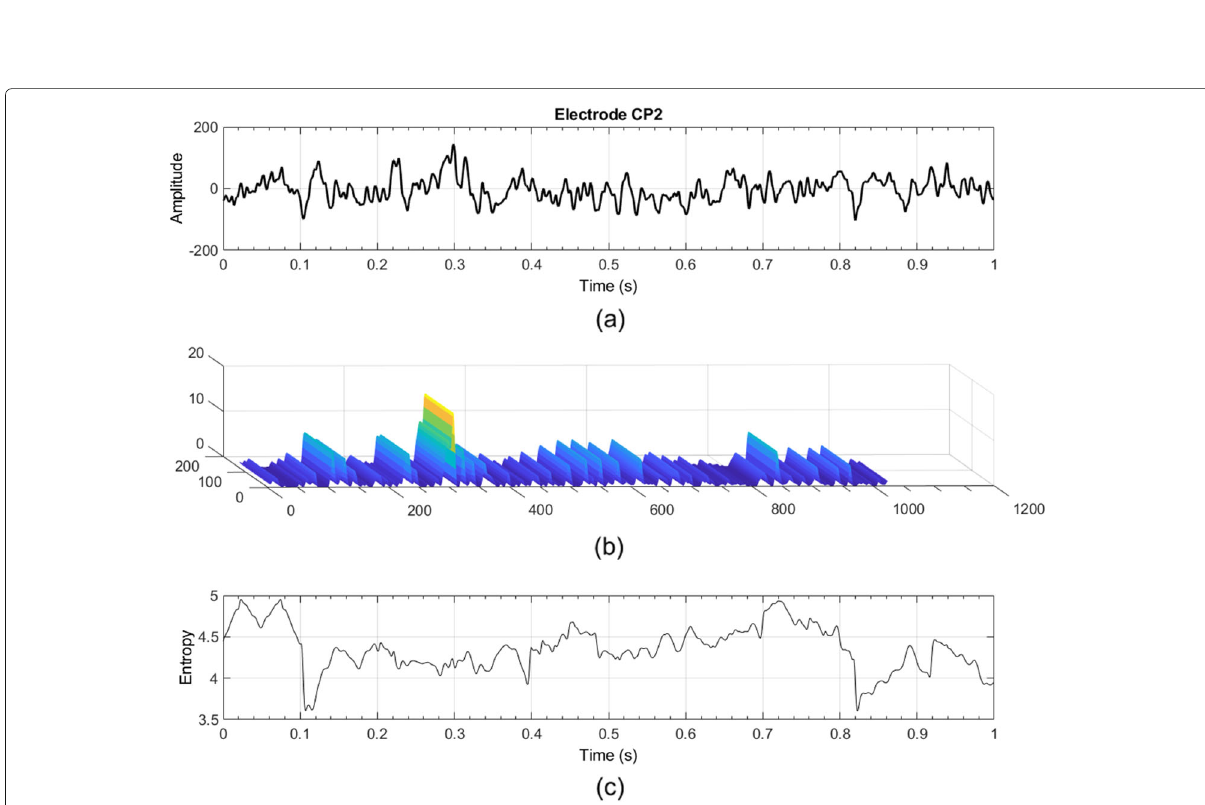
Fig. 8 Electrode CP2. a Time domain representation of ERP. b SPWVD time-frequency representation. c Short-term Rényi entropy of the